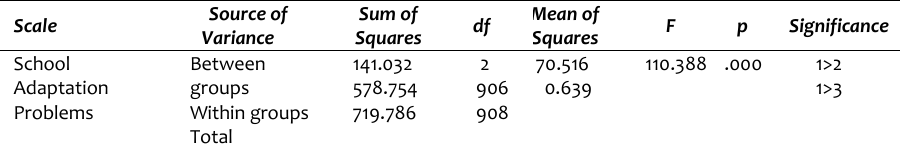
Table 3. ANOVA Results Concerning Primary School Students' School Adaptation Problems According to Age Groups